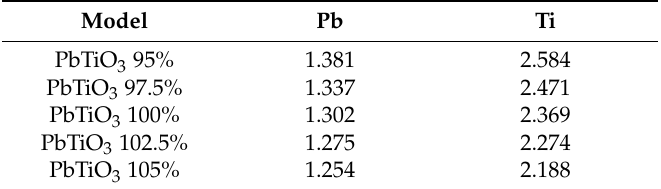
Figure 5. Case similar to 3 d 0 of Ti 4+ : ( a ) histogram of the effective charges of the cations of strained and unstrained PT, ( b ) physical and chemical image of energy gain and loss with respect to strain. ( a ) was drawn by using the values in Table 6. r , r c , r e in ( b ) are the distance between the two ions in general meaning, the distance in the compressed state, that in the expanded state, respectively. Table 6. Effective charges of PT (PbTiO 3 ) for each ratio of the isotropic deformation.